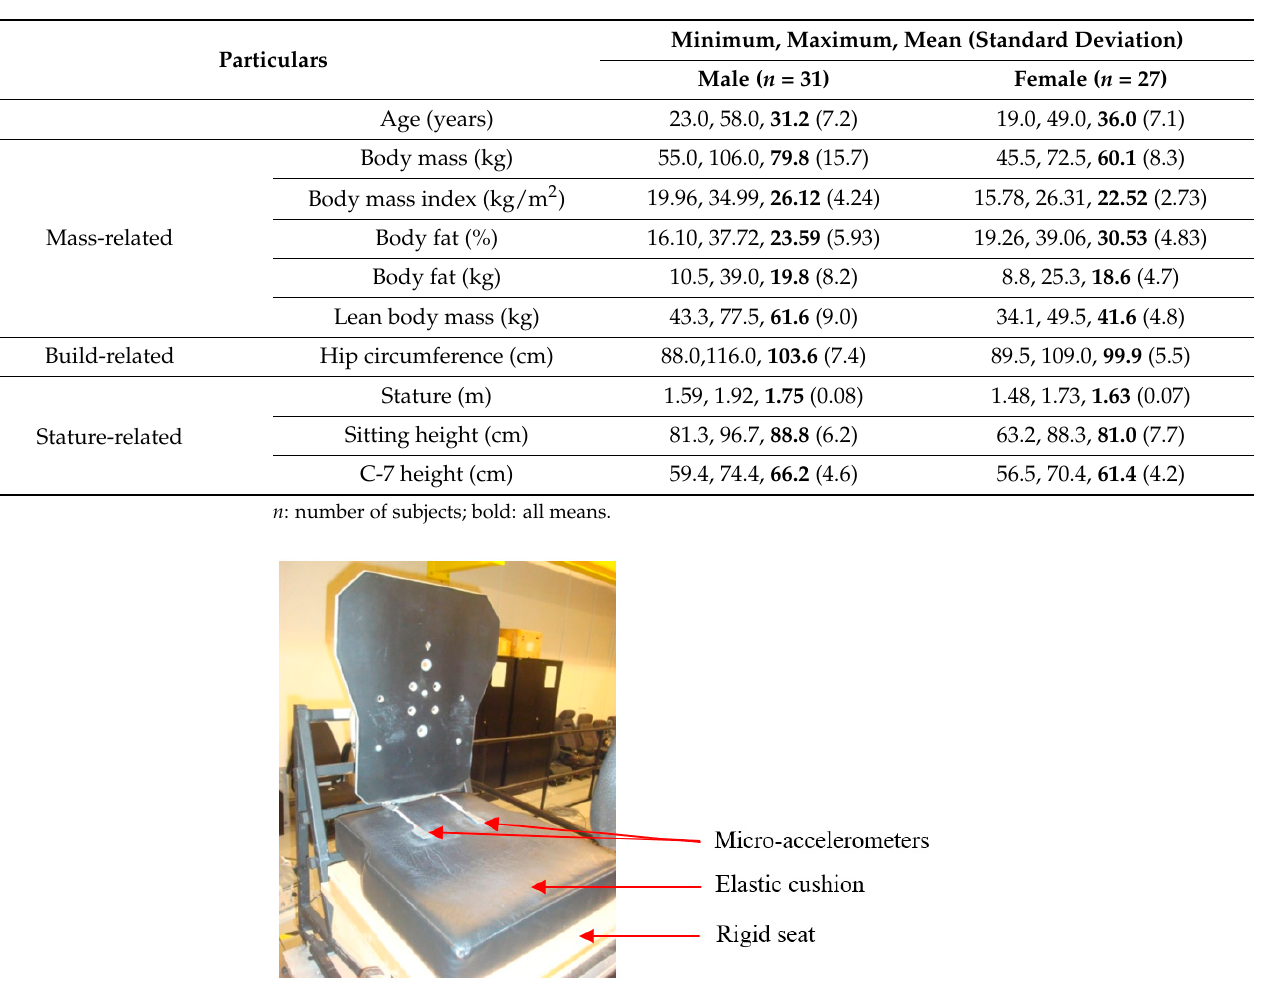
parameters of the participants.